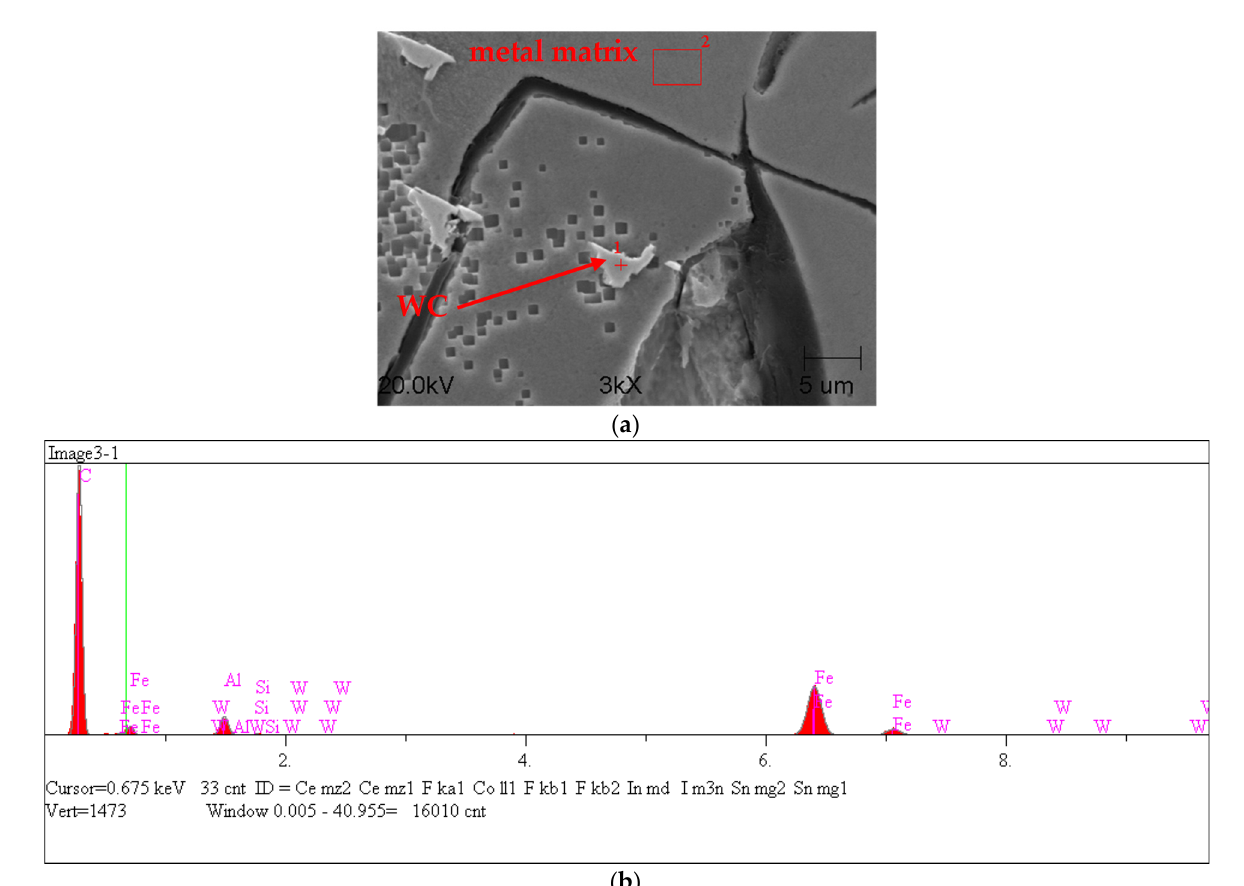
Figure 10. SEM microstructures of high-aluminum cast iron with the addition of tungsten ( a ) graphite in the structure and its EDS X-ray microanalysis ( b ).